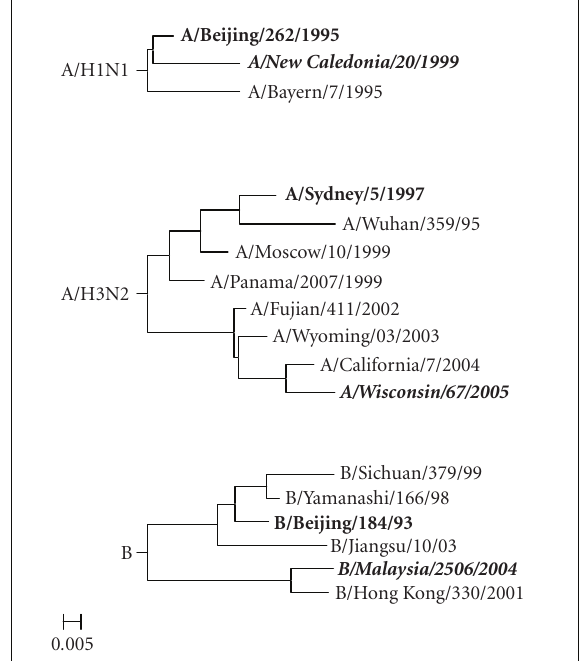
Figure 1: Hemagglutinin phylogenetic trees of the strains recom- mended for NH vaccine formulation from 1997/1998 to 2006/2007 influenza